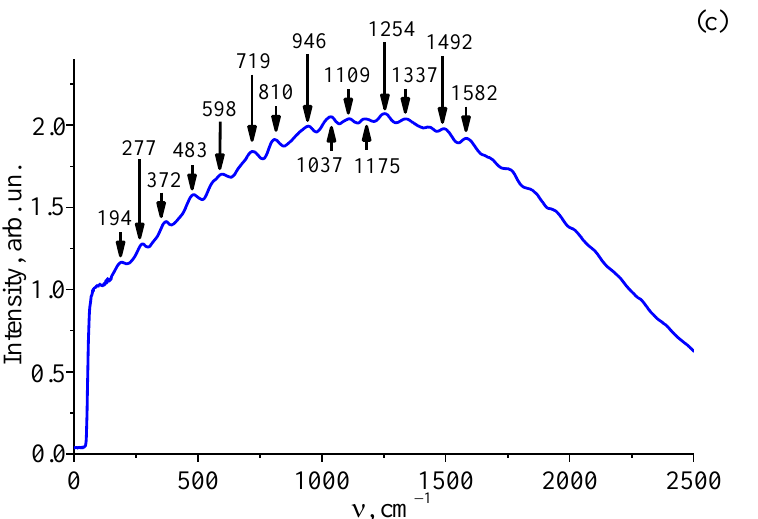
Figure 2. Raman spectra in the region of fundamental modes for 180-degree scattering (backscattering) of LiTaO 3 :Cr(0.2):Nd(0.45 wt%) crystal with scattering geometries x ( zz , zy ) x ( a ), y ( zz , zx ) y ( b ), and z ( xx , yy , xy ) z ( c